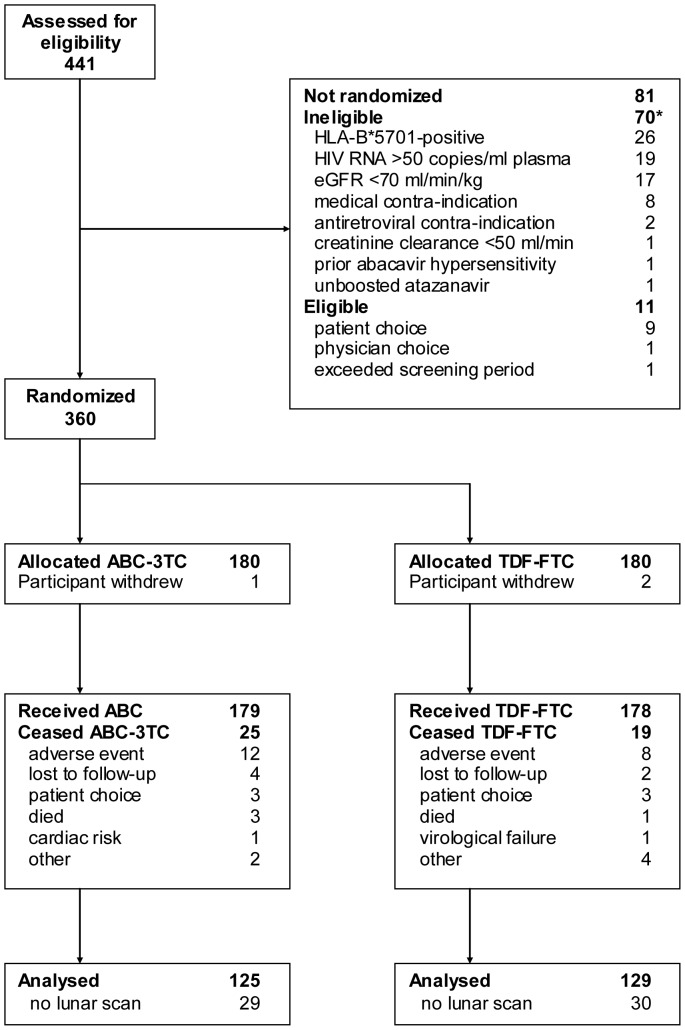
Patient disposition.